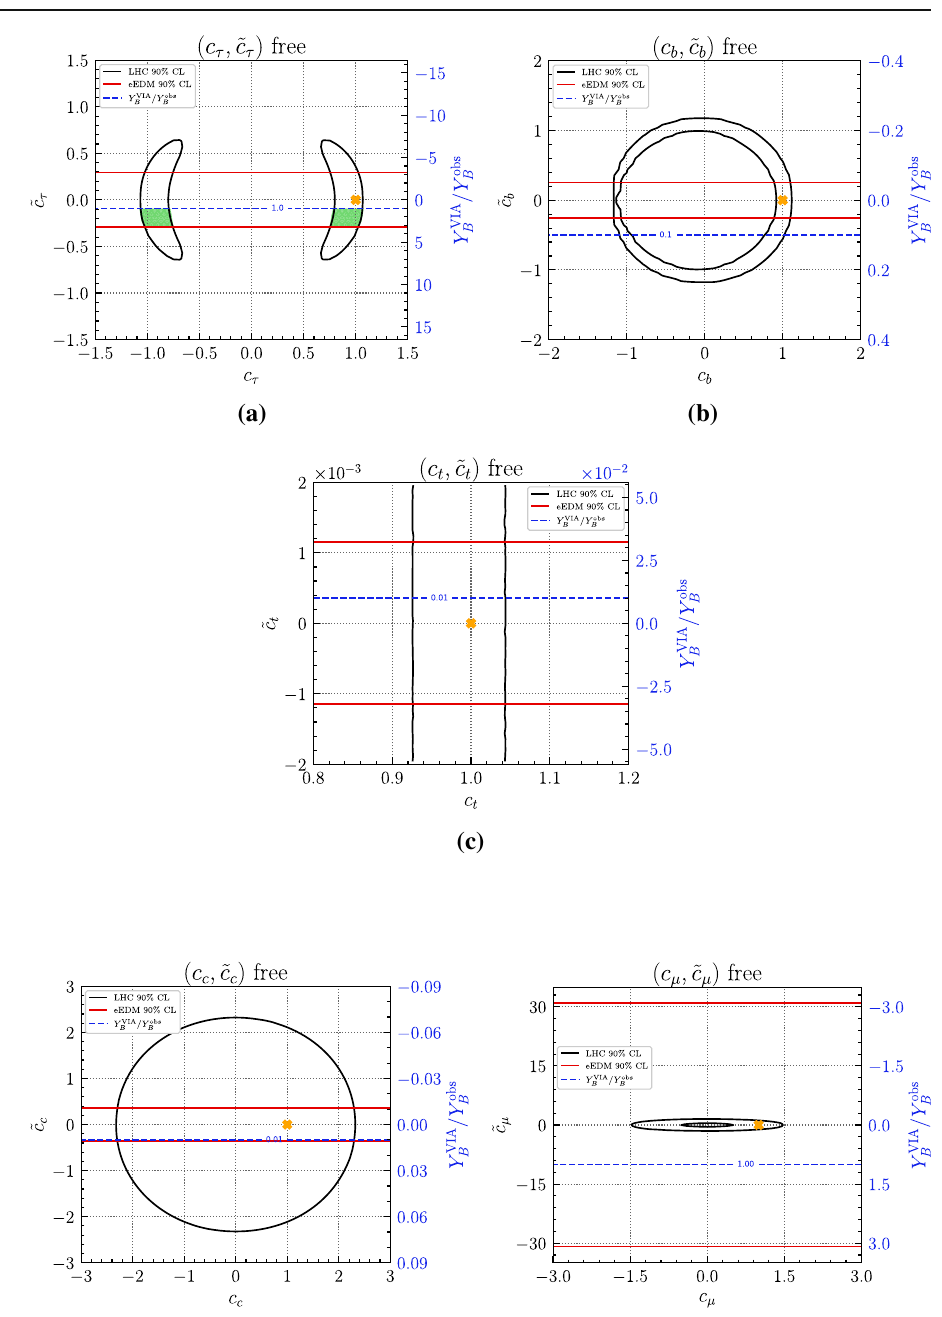
/ Y obs (cid:2) B B